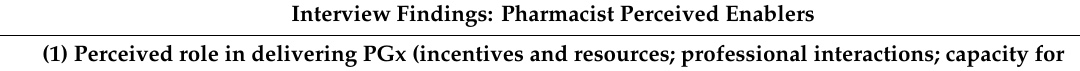
Table 4. Illustrative quotes of emergent enabler themes and their congruent Tailored Implementation for Chronic Diseases (TICD)